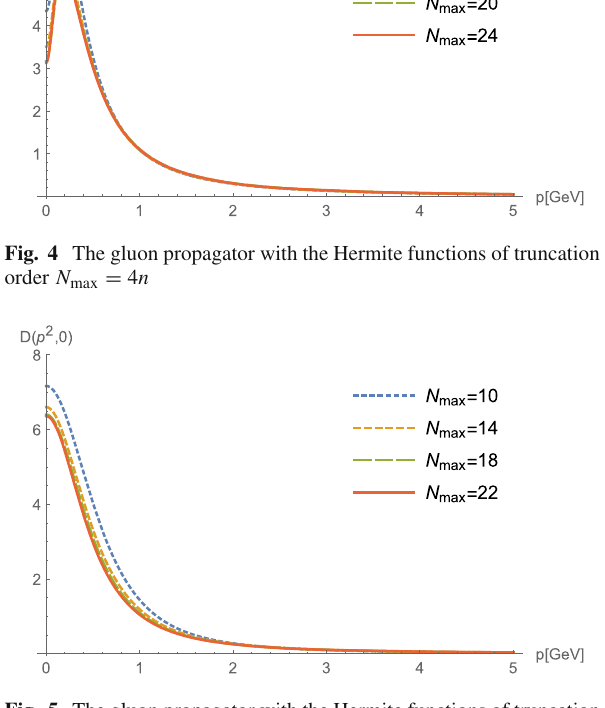
Fig. 5 The gluon propagator with the Hermite functions of truncation order N max = 4 n +